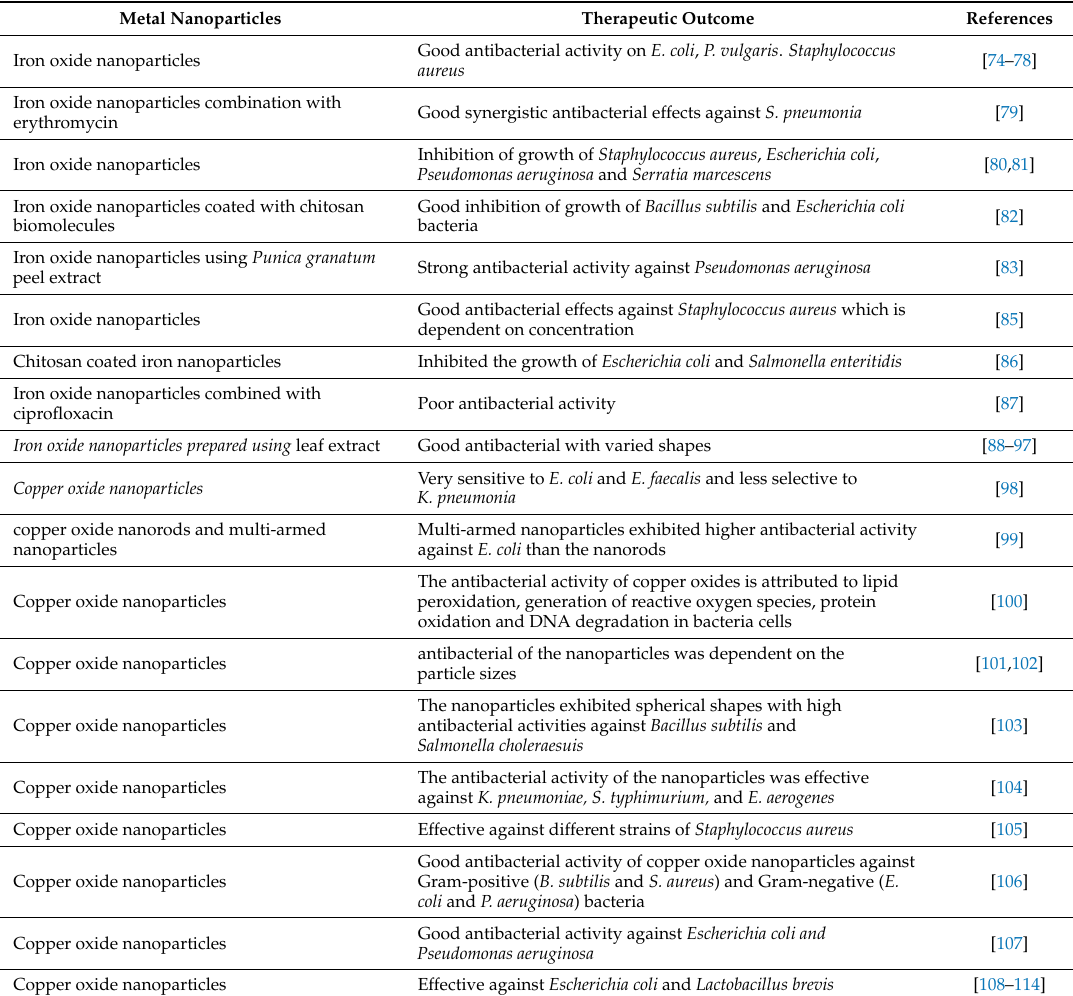
Table 2. Iron oxide and copper oxide nanoparticles with antibacterial